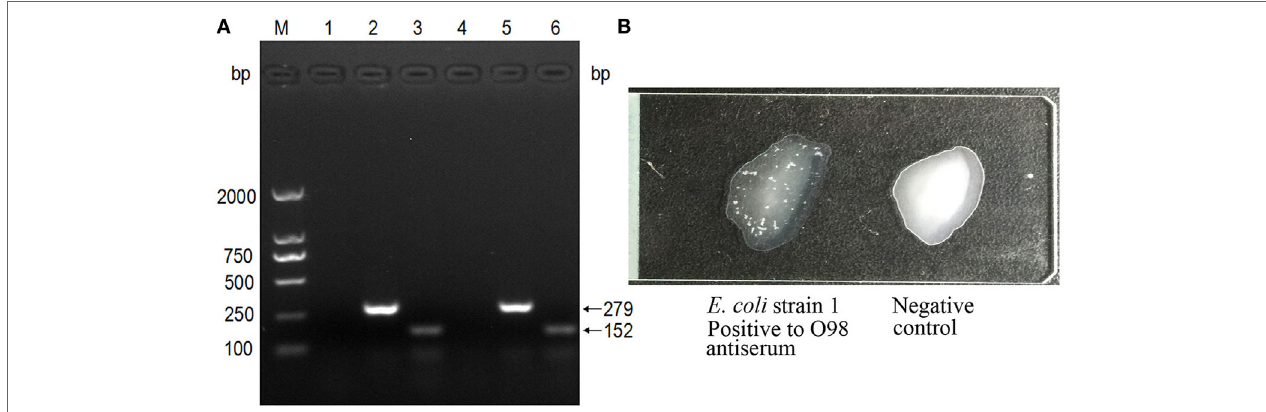
FigUre 2 | Genotyping and serotyping of Escherichia coli isolates. (a) The triplex PCR specific for E. coli phylogenetic groups. (M) DNA ladder (DL2000); lanes 1–3: PCR products with primers specific to the genes yjaA , ChuA , and TspEC2 , using the template of strain 1; lanes 4–6: PCR products with primers specific to the genes yjaA , ChuA , and TspEC2 , using the template of strain 2. (B) The strains were typed by the slide agglutination test with standard antisera against all antigens of enteropathogenic E. coli (EPEC), enterotoxigenic E. coli (ETEC), enterohemorrhagic E. coli (EHEC), enteroinvasive E. coli (EIEC), enteroaggregative E. coli (EAEC), and diffuse-adhering E. coli (DAEC) of O1–O163. The left was O98 positive, shown by the apparent white agglutinating clusters, while the right was